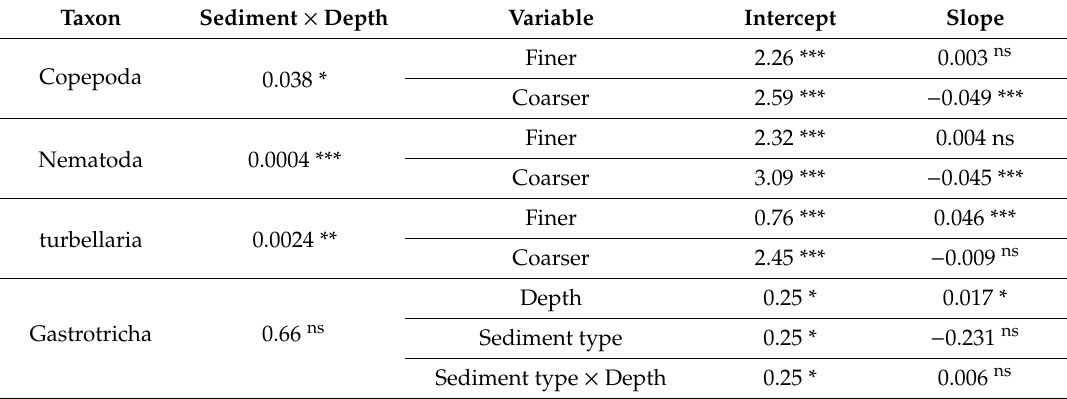
Table 7. Turbellarian species (undescribed species listed with helping names) found in finer and coarser sediments in the lower intertidal of EI in March 2012. Numbers represent the mean (±1 SE) number of individuals per 25 mL.